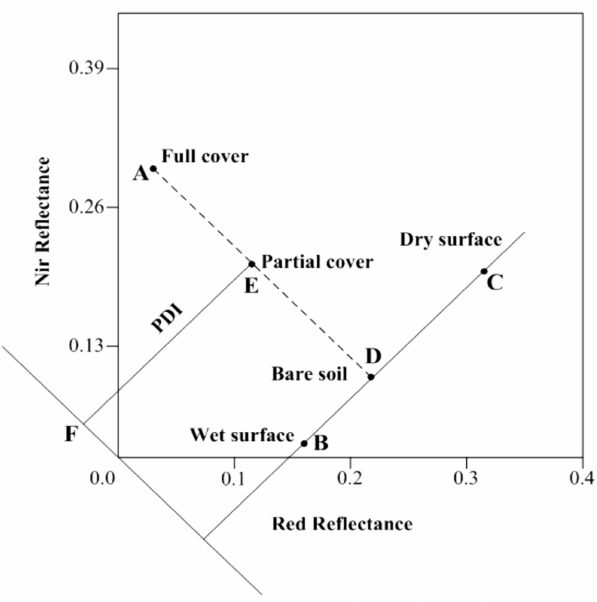
Figure 2. Definition of the PDI. Adapted from [26]. Reprinted with permission from ref. [26]. Copyright 2006,